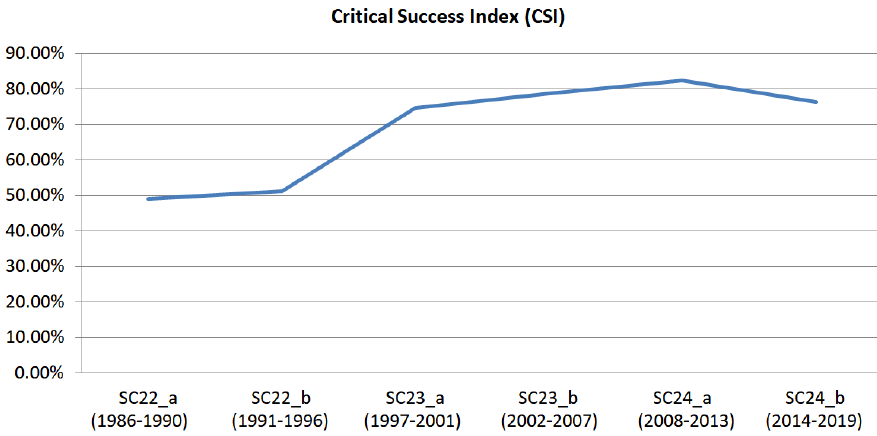
Figure 3. CSI forecasting performance of UMASEP-10 version 2 for each half of the three solar cycles.